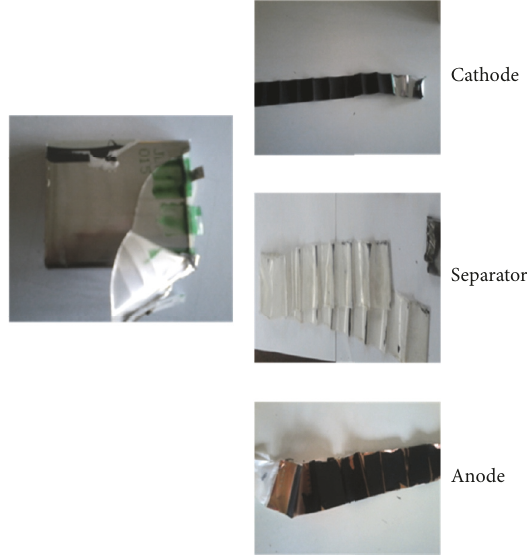
Figure 2: Cathode, anode, and separator from a cell phone spent LIB used in this